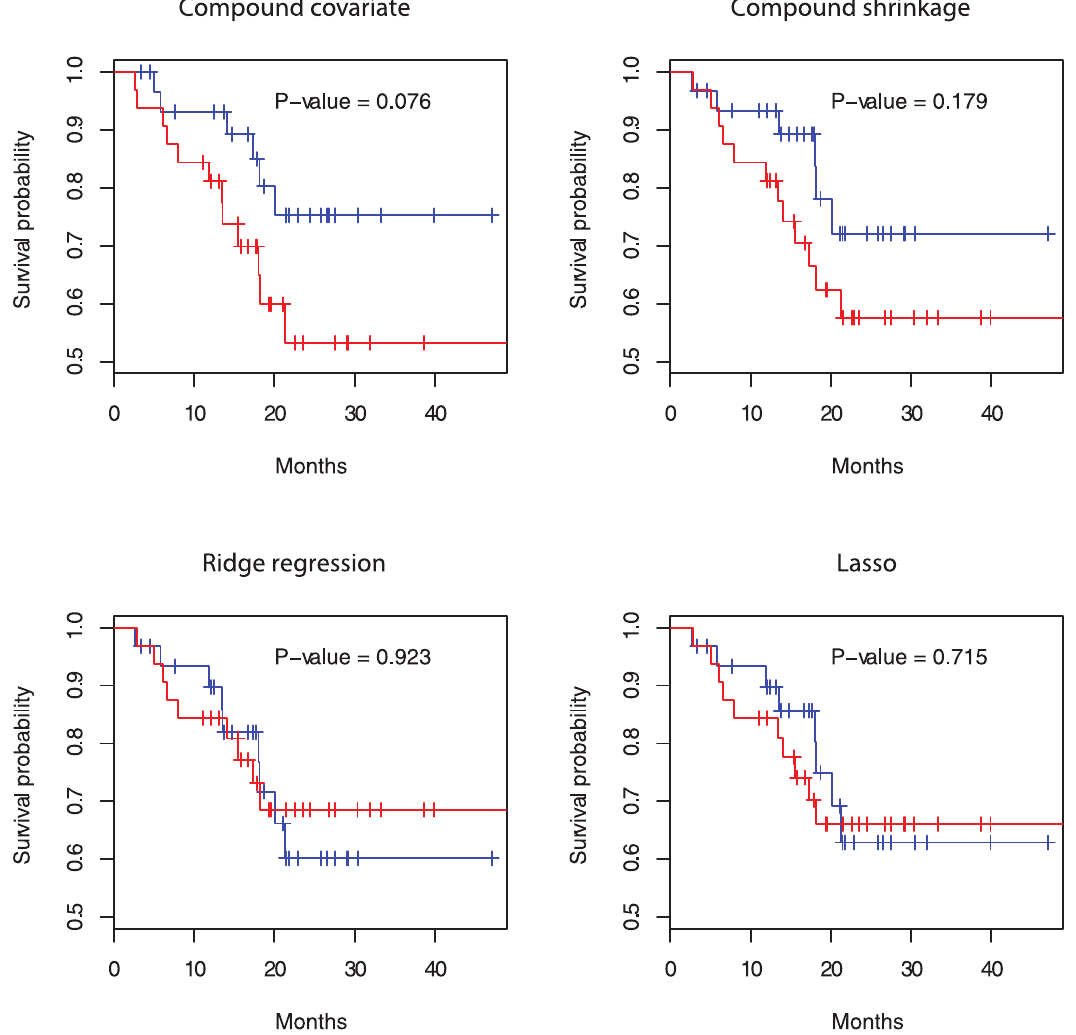
Figure 2. Kaplan-Meier curves for the 62 patients in the lung cancer data of Chen et al. [ 6 ] . Good (blue) and poor (red) groups are determined by the median of the PI’s in the test dataset.